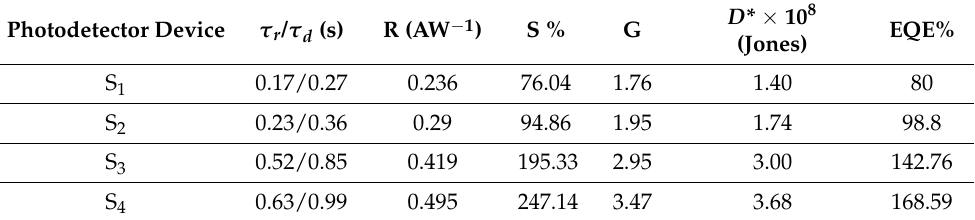
Table 5. The significant parameters for a set of considered four devices based on UV photodetectors S 1 , S 2 , S 3 , and S 4